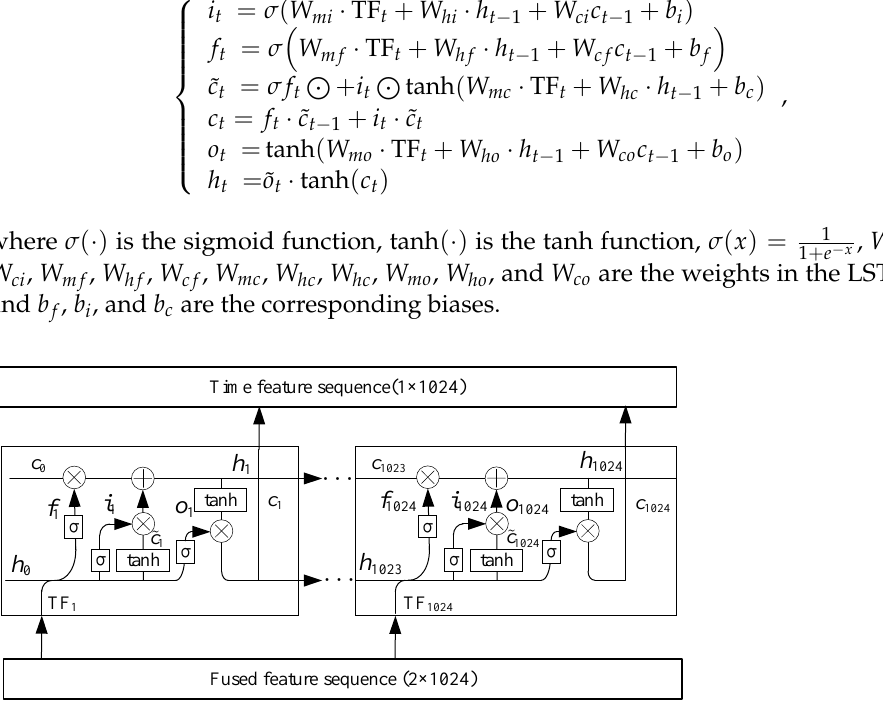
Figure 5. LSTM network-based time series feature